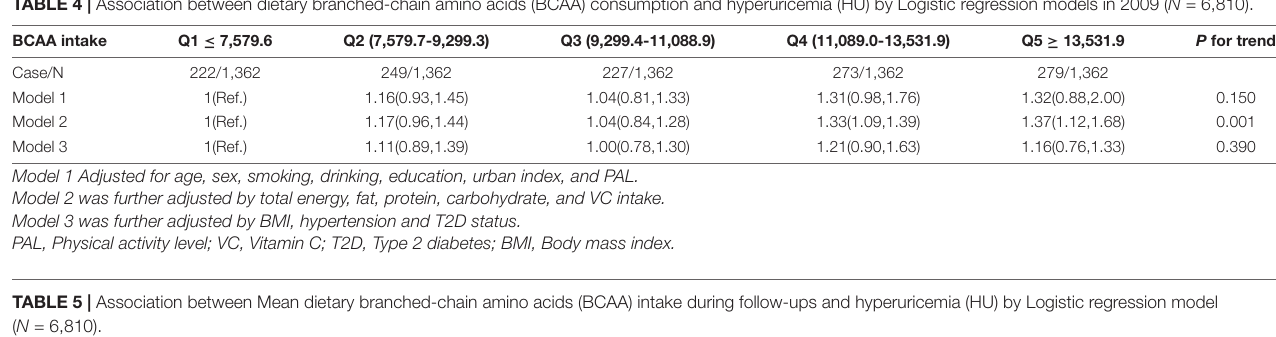
TABLE 4 | Association between dietary branched-chain amino acids (BCAA) consumption and hyperuricemia (HU) by Logistic regression models in 2009 ( N = 6,810).